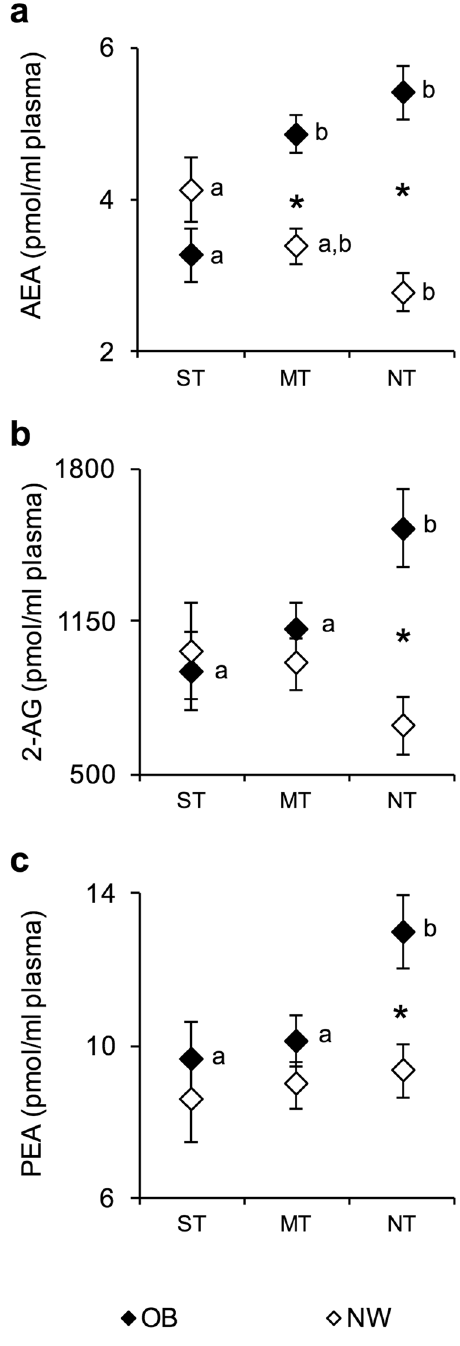
Figure 2. Mean values ± SEM of endocannabinoids (AEA and 2-AG) and the palmitoylethanolamide (PEA) congener plasma levels measured in supertaster ( N = 9), medium taster ( N = 28) and non-taster ( N = 23) participants with normal weight (NW) and supertaster ( N = 12), medium taster ( N = 25) and non-taster ( N = 13) participants with obesity (OB). ( a ) Anandamide (AEA) values. ( b ) 2-arachidonoylglycerol (2-AG) values. ( c ) PEA values. A two-way analysis of variance (ANOVA) was used to compare the differences across taster groups in participants with normal weight or with obesity (AEA and 2-AG: P < 0.009). The different letters indicate significant differences (AEA: P < 0.019; 2-AG: P = 0.044; and PEA: P = 0.020; Newman-Keuls test). * A significant difference between participants with normal weight or with obesity ( P < 0.017; Newman- Keuls test). ST, supertaster participants; MT, medium taster participants; and NT, non-taster